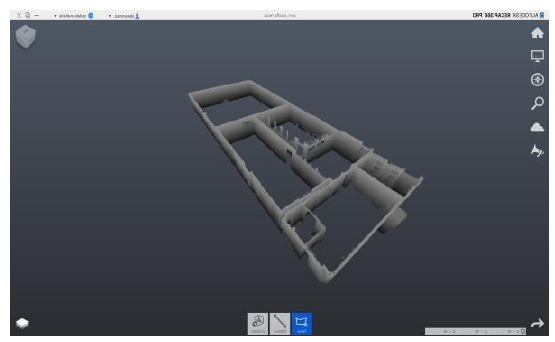
Figure 8: The parcel acquired from MLS viewed in Autodesk